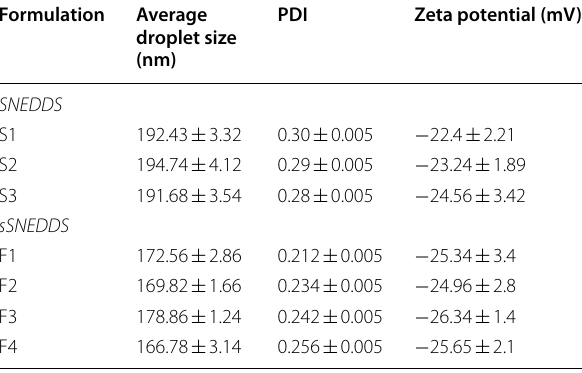
All the results presented in the table are average of three experiments and values are presented as mean